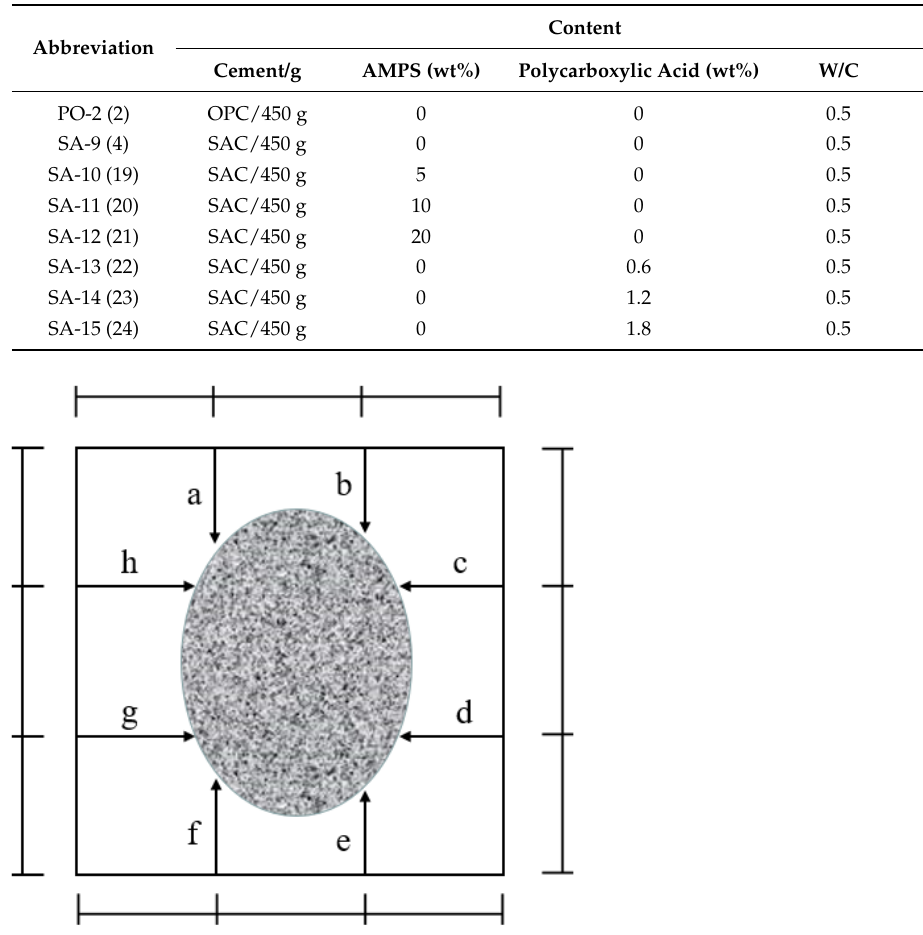
Table 3. List of cement mortar ingredients.